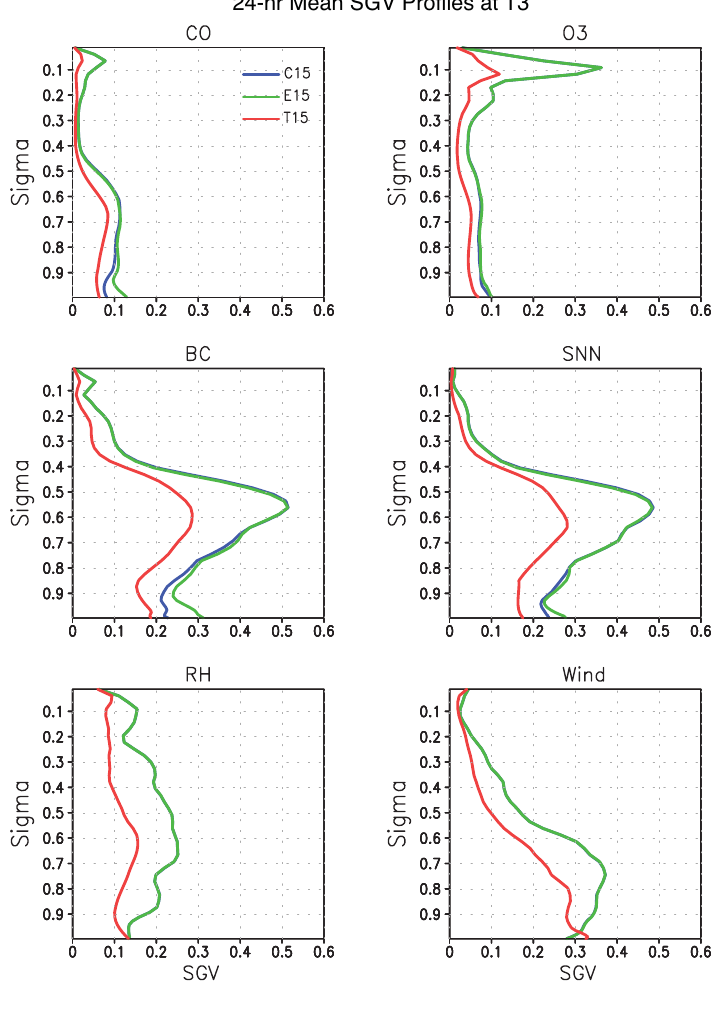
Fig. 17. Same as Fig. 16 but over site